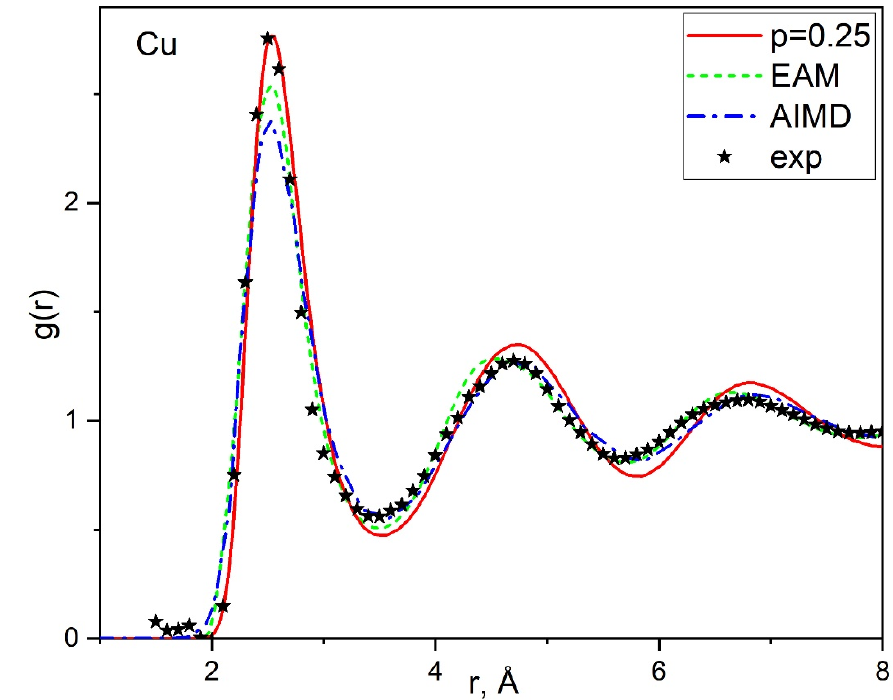
Metals 2021 , 11 , x FOR PEER REVIEW 12 of 17 Figure 11. Structure factor of liquid Au at T = 1423 K and p = 1 in comparison with experiment [38]. Figure 11. Structure factor of liquid Au at T = 1423 K and [38].